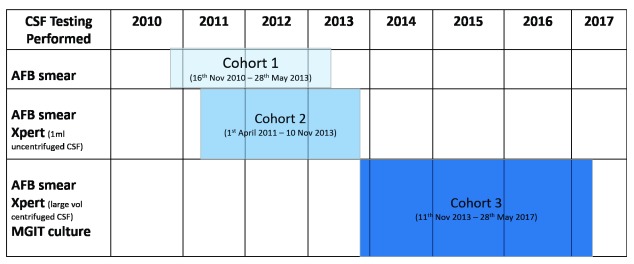
Timeline illustrating evolution of diagnostic testing.